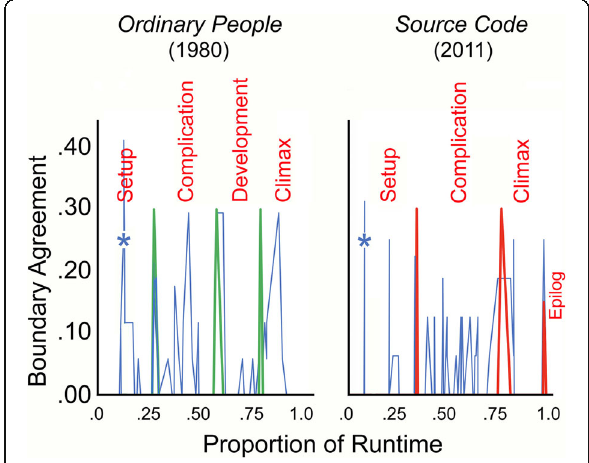
Fig. 3 The correspondence between viewer segmentations ( thin blue spikes ) and segmentations for two more recent films that follow the rubrics of Thompson (1999) and Bordwell (2006) in the left panel , and that correspond to Bordwell ’ s (2011) segmentations in the right